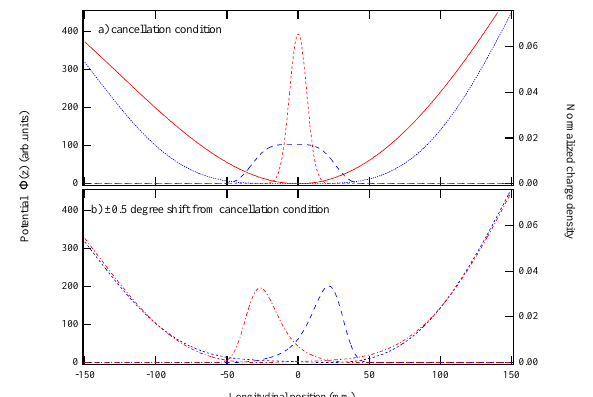
FIG. 3. (Color) Potential well and longitudinal distribution for (a) optimum voltage and phase for bunch flattening and (b) 6 0.5 ± shift from optimum